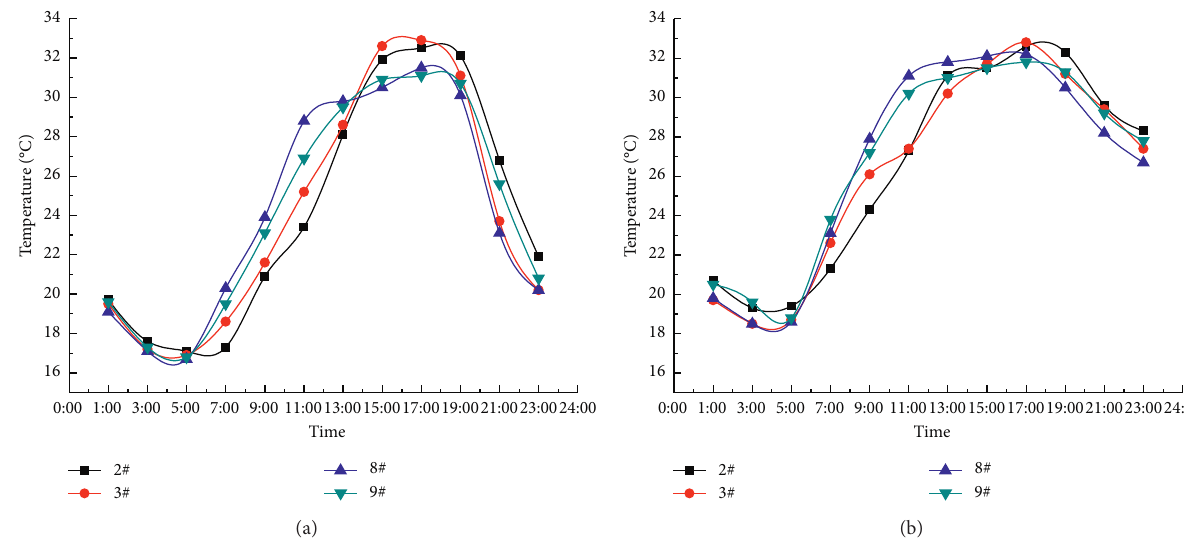
Figure 8: Curves of measuring points and ambient temperature with time. (a) Local temperature field on June 7. (b) Local temperature field on June